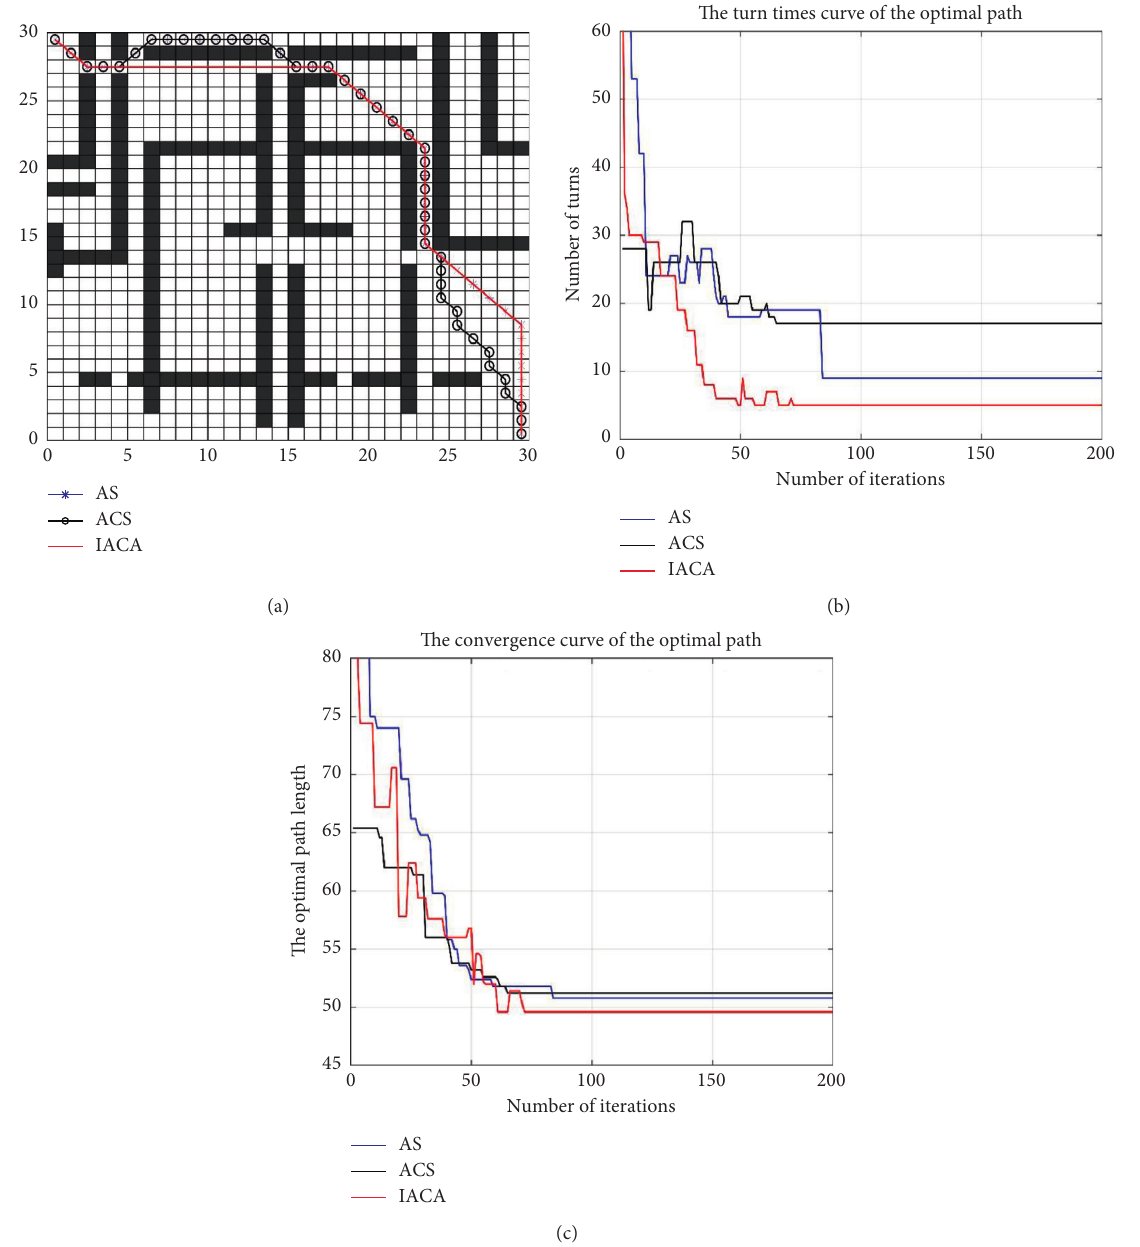
Figure 5: Results of path planning about three algorithms (30 × 30). (a) Path planning in three algorithms (30 × 30). (b) The turns times curve about three algorithms (30 × 30). (c) The convergence curve about three algorithms (30 ×